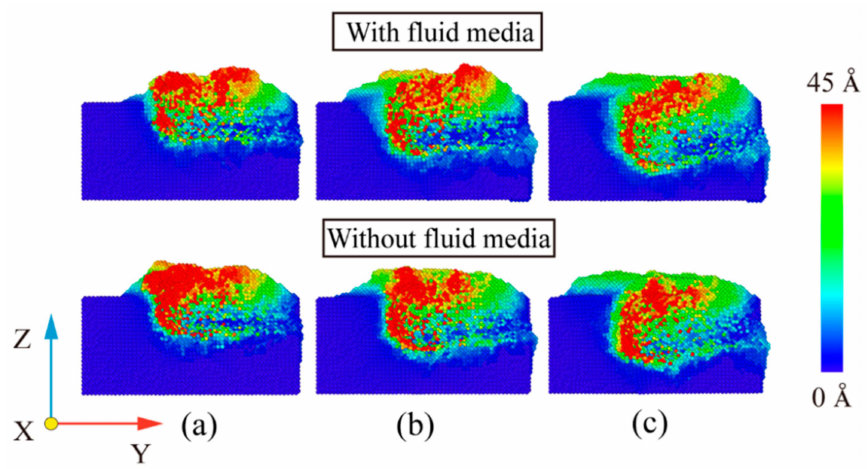
Figure 11. Atomic displacement of cross-section when cutting distance of 10 nm. ( a ) θ = 0 ◦ ; ( b ) θ = 5 ◦ ; and ( c ) θ = 10 ◦